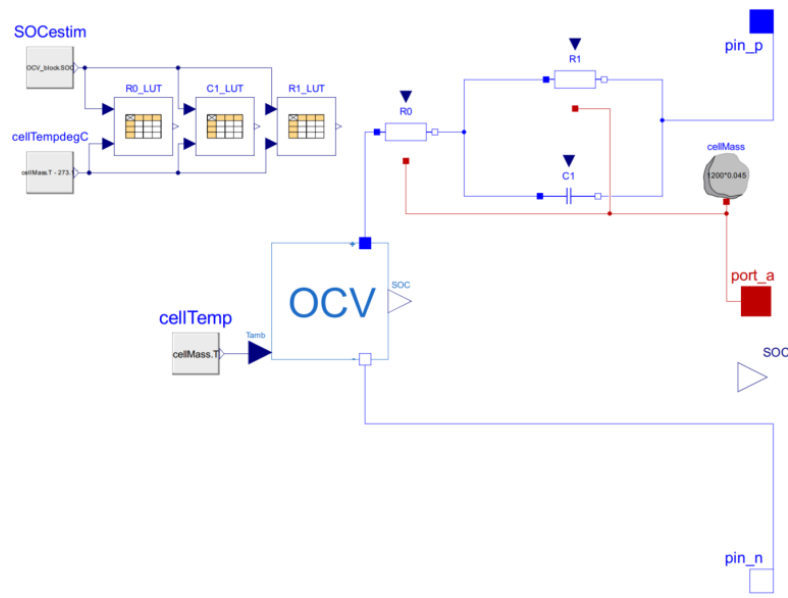
Figure 7. The equivalent circuit model with a single RC branch used for this study.